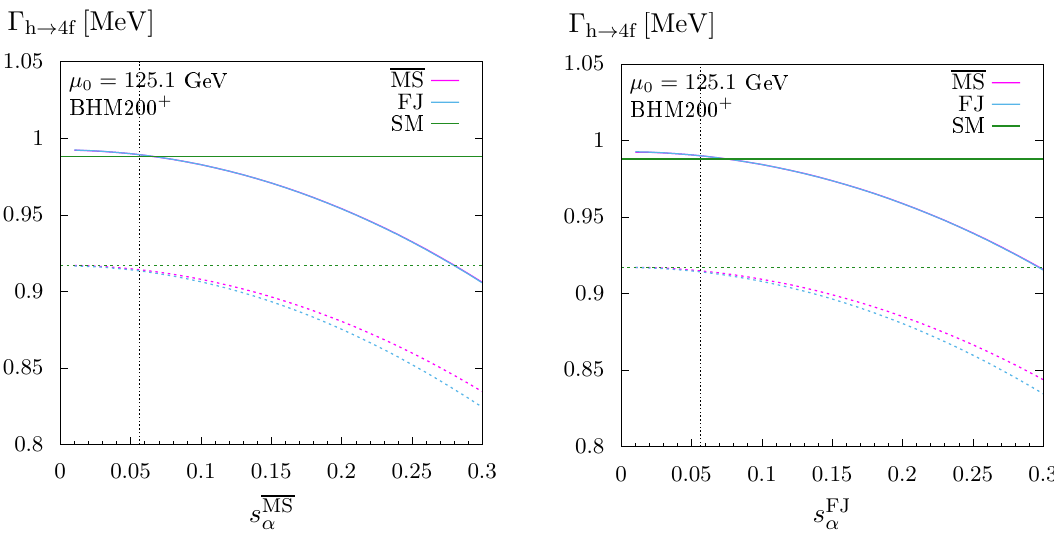
Figure 12 . Dependence of the decay width (cid:0) h ! 4 f at LO and NLO EW+QCD with respect to the variation of s (cid:11) . Free parameters other than s (cid:11) are (cid:12)xed according to benchmark scenario BHM200 + (see table 2). On the left (right) the input parameters are de(cid:12)ned in the MS (FJ) scheme and converted to the FJ (MS) scheme (both for LO and NLO predictions). The vertical dashed line signals that for s (cid:11) . 0 : 06 perturbativity problems might